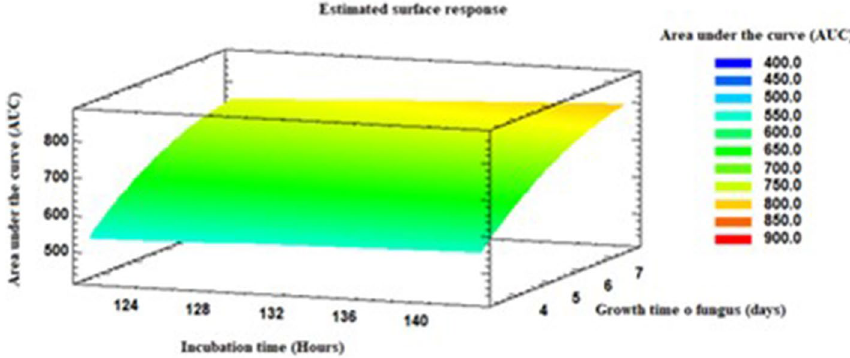
Figure 8. Response surface graphs. Effect growth time of the fungus in the synthesis of AgNPs.